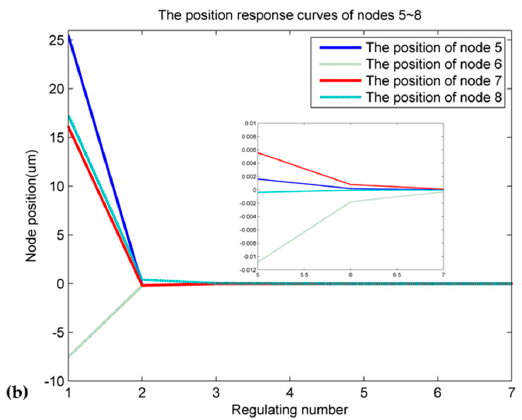
Figure 7. The position adjustment curve of nodes 1–8: ( a ) the position response curves of nodes 1–4; ( b ) the position response curves of nodes 5–8.